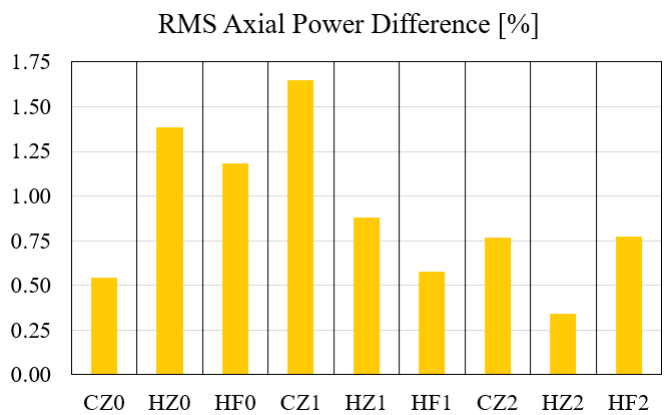
Figure 21. RMS axial power differences for each case condition. Figure 21 indicates that generally, axial power agreement increases as boron concen- tration